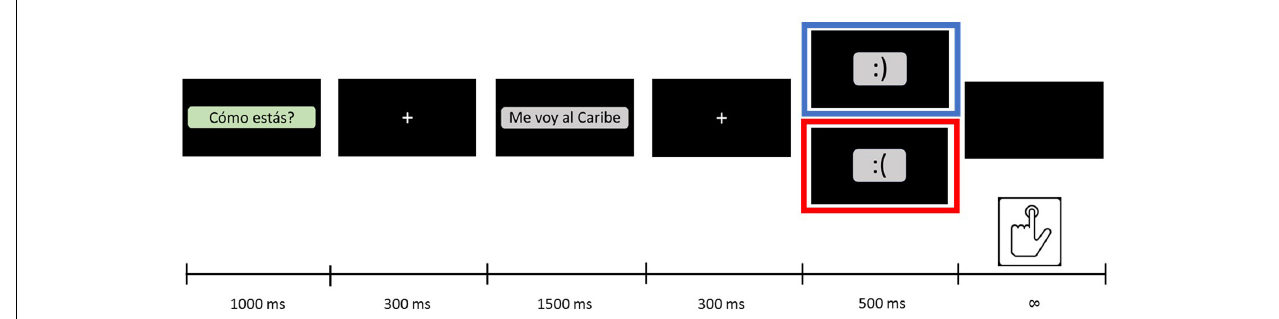
FIGURE 2 | Experimental trial. Sequence of events on each trial. Time of presentation is represented in milliseconds (ms). Blue corresponds to congruent emoticon, and red corresponds to incongruent